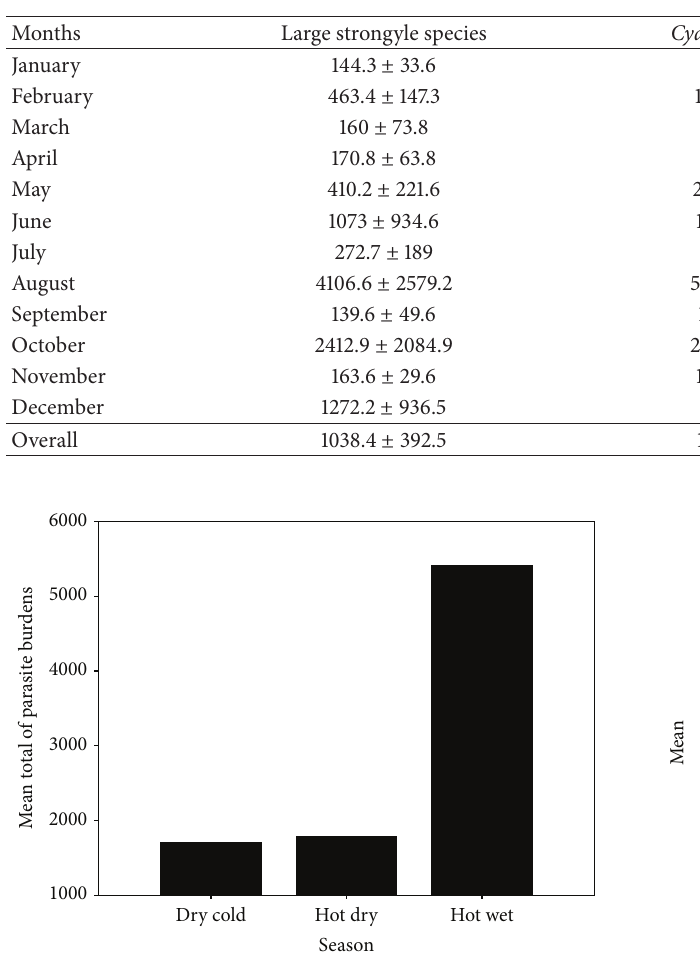
Table 5: Monthly mean worm count ± SEM of parasites recovered from colon of necropsied donkeys.